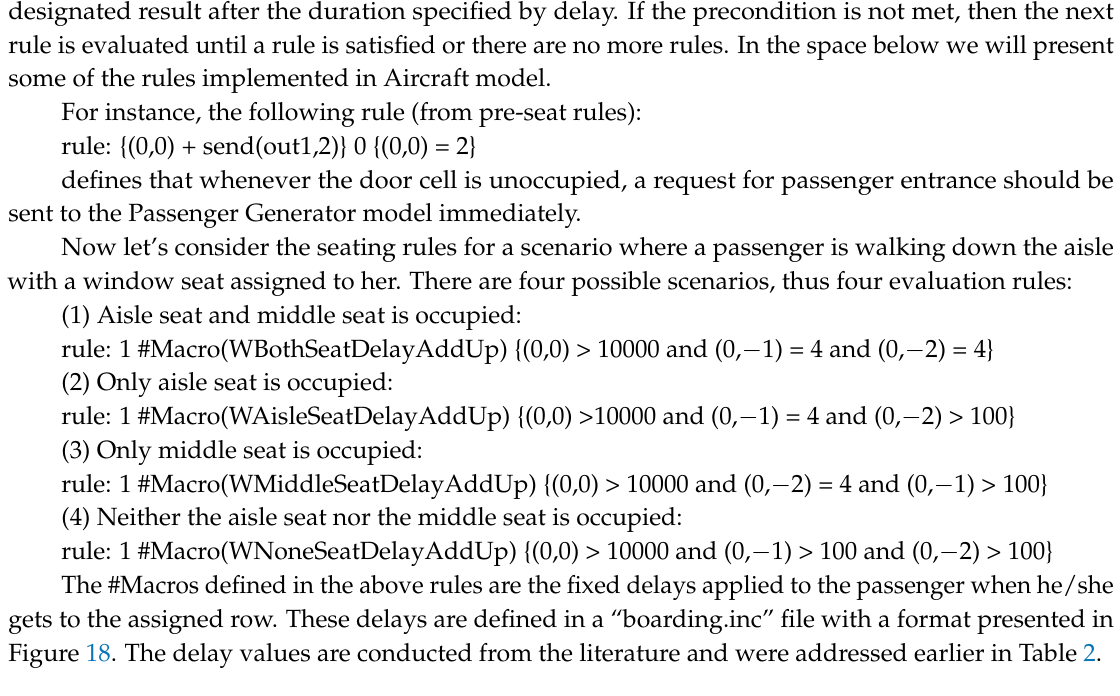
Figure 18. Sample macros defining various delay values based on Table 2 ranges. In order to execute the simulations, a model file is created, providing DEVS top level structure where Passenger Generator and Cellular Aircraft models are connected through coupling. CD++ allows creating and editing model file by providing syntax checking mechanism. Another file that